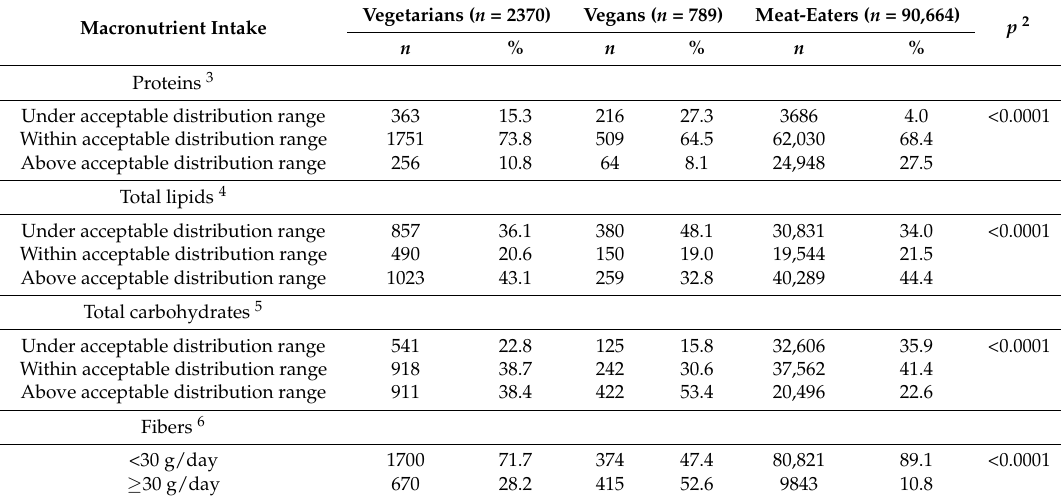
Table 6. Proportion of individuals under, within, and above acceptable ranges of macronutrient intakes according to the French nutritional recommendations for adults 1 among vegetarians, vegans, and meat-eaters (Nutrinet-Sant é Study 2009–2015, n = 93,823). Macronutrient